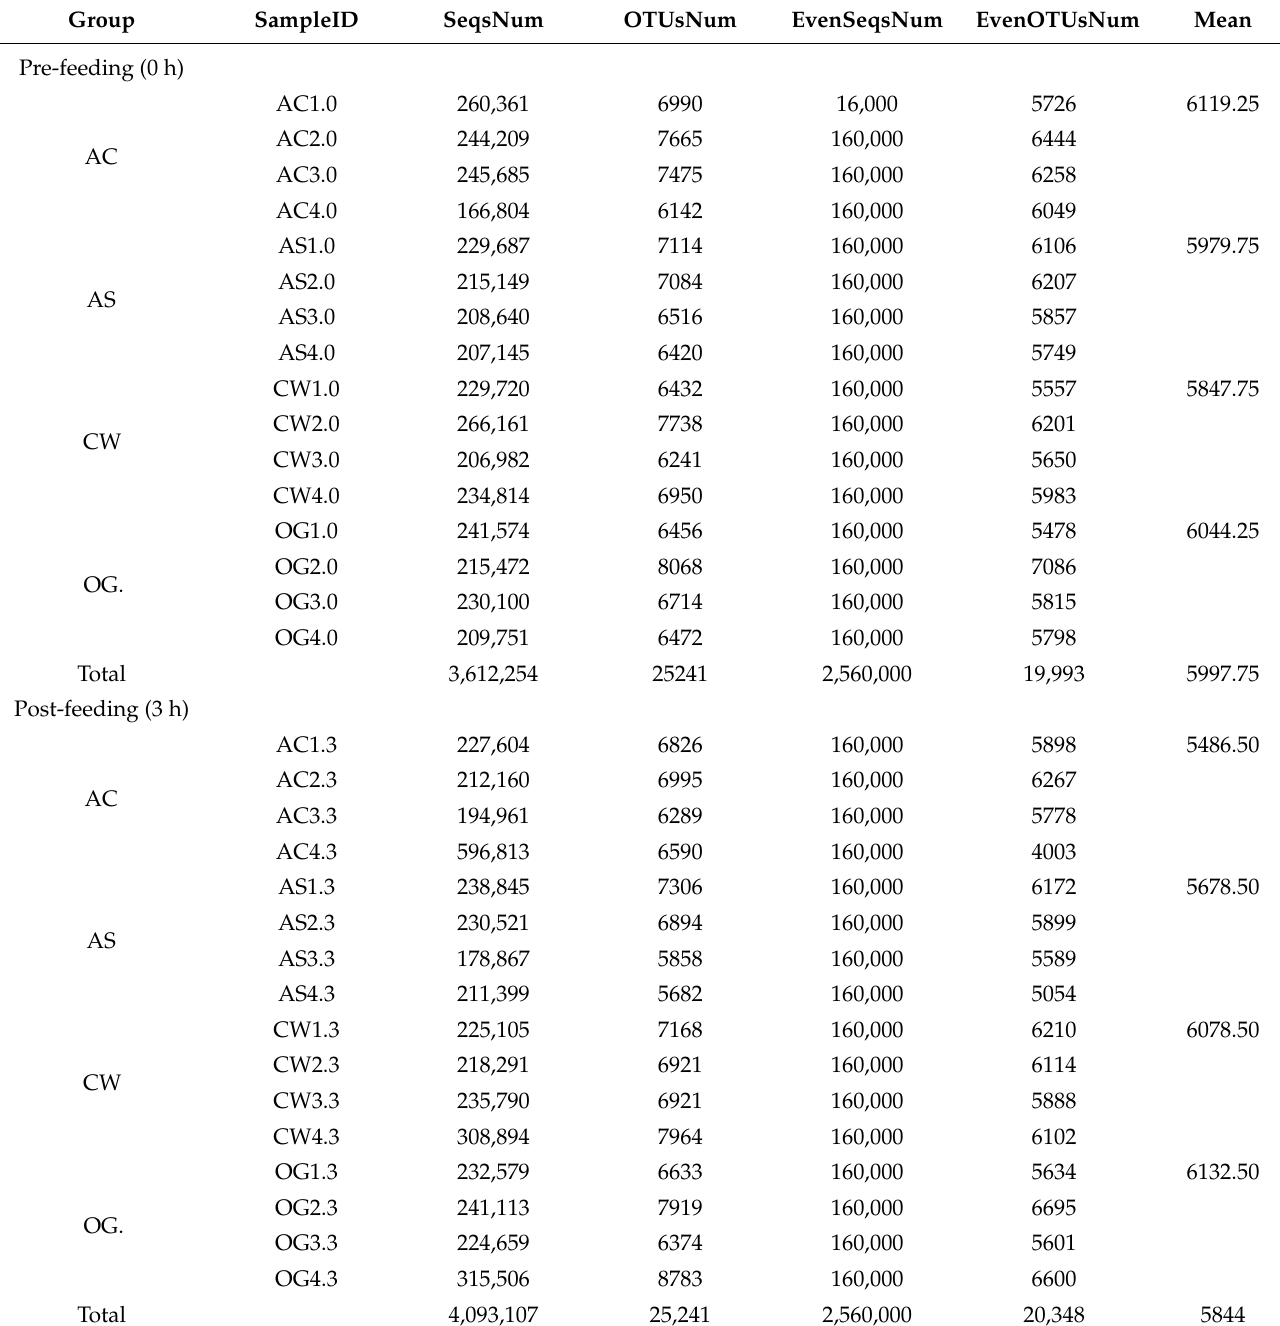
Table 8. Reads and OTU number of samples on threshold of 97% 5